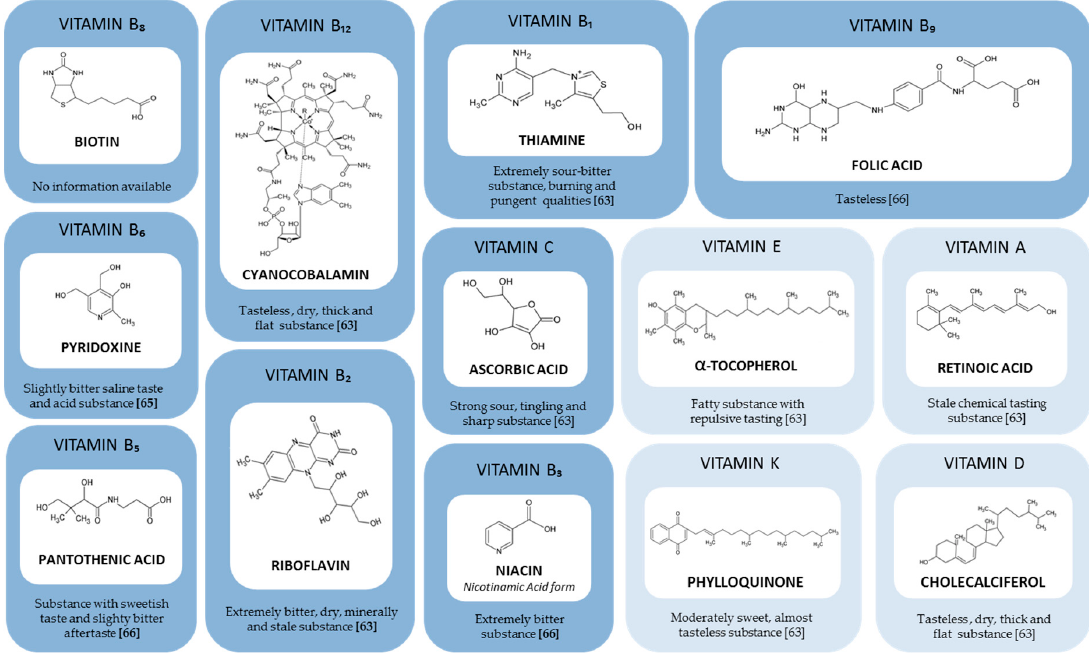
Figure 2. Chemical structures and taste qualities of 13 vitamins. Vitamins have been classified according to their solubility. water-soluble vitamins , fat-soluble vitamins.